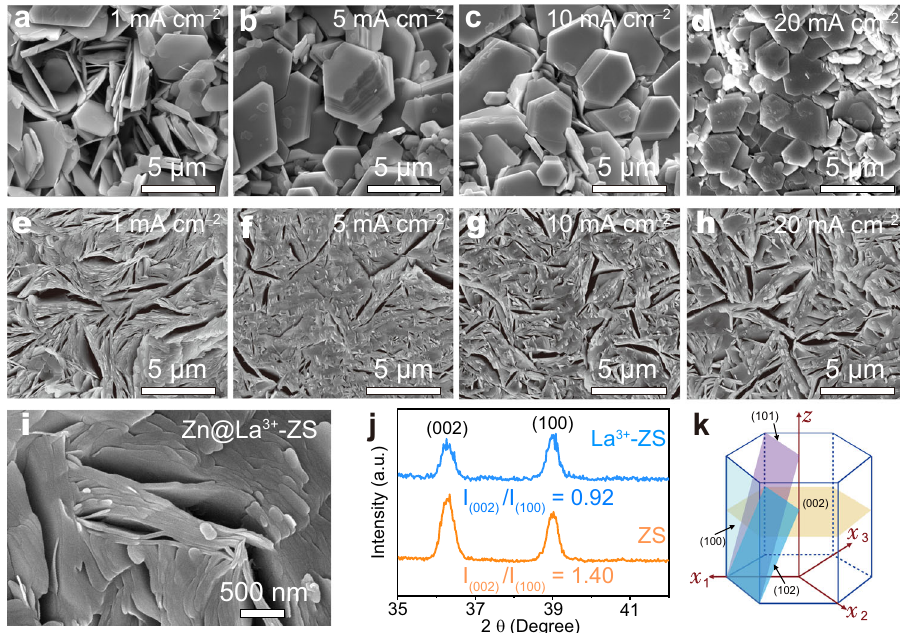
Fig. 2 The morphology analysis of Zn deposits. The SEM images of Zn deposits from the Zn electrodes of Zn||Zn cells with a fi xed areal capacity of 1 mAh cm − 2 and different current densities from 1 to 20 mA cm − 2 in ( a – d ) ZS and ( e – h ) La 3 + -ZS electrolytes. i The high-magni fi cation SEM image of the Zn electrode for a Zn||Zn cell in La 3 + -ZS electrolyte after 10 cycles under a current density of 1 mA cm − 2 for 1 h. j GIXRD patterns of Zn deposits from the Zn electrodes of a Zn||Zn cell under a current density of 1 mA cm − 2 for 1 h showing the reduced (002) planes in La 3 + -ZS electrolyte. k The illustration of the hexagonal close packed (hcp) structure of